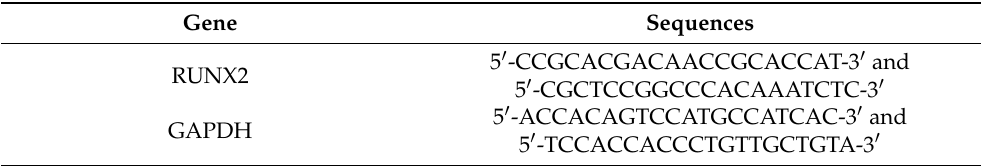
Table 1. Sequences of the primers used in